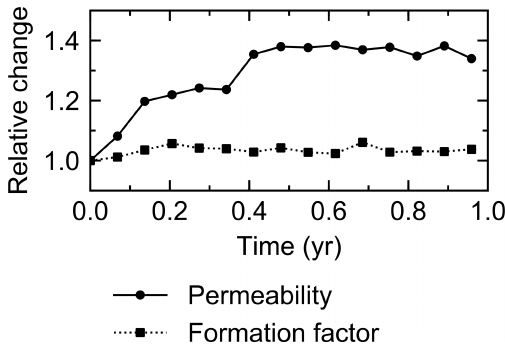
Figure C2. Relative changes of permeability and formation factor in the default simulation (simulation a in Sect. 3.1).